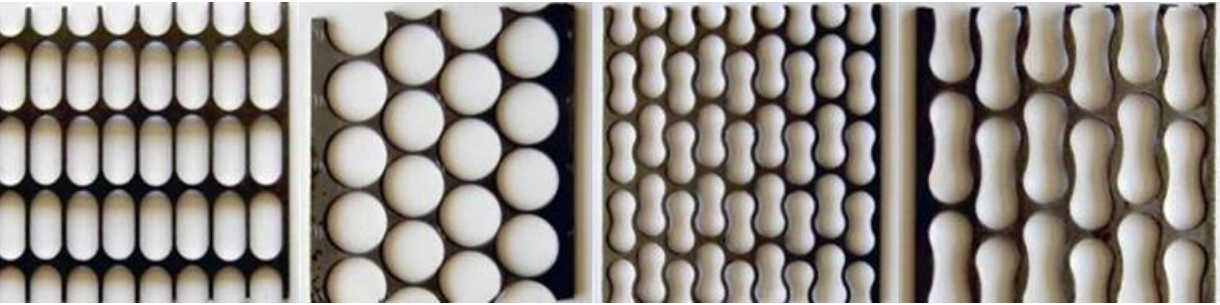
Figure 3. The estimated growth of the global stamped metal market [25] .